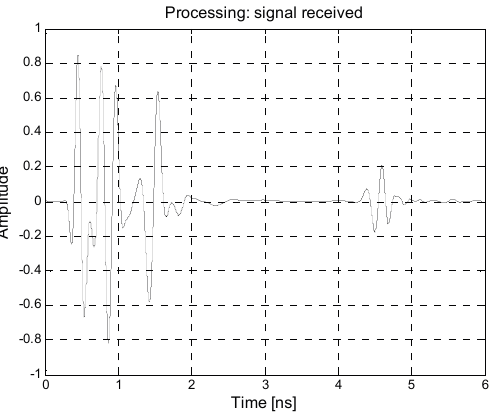
Figure 21. Example of received waveform in the absence of external EMI